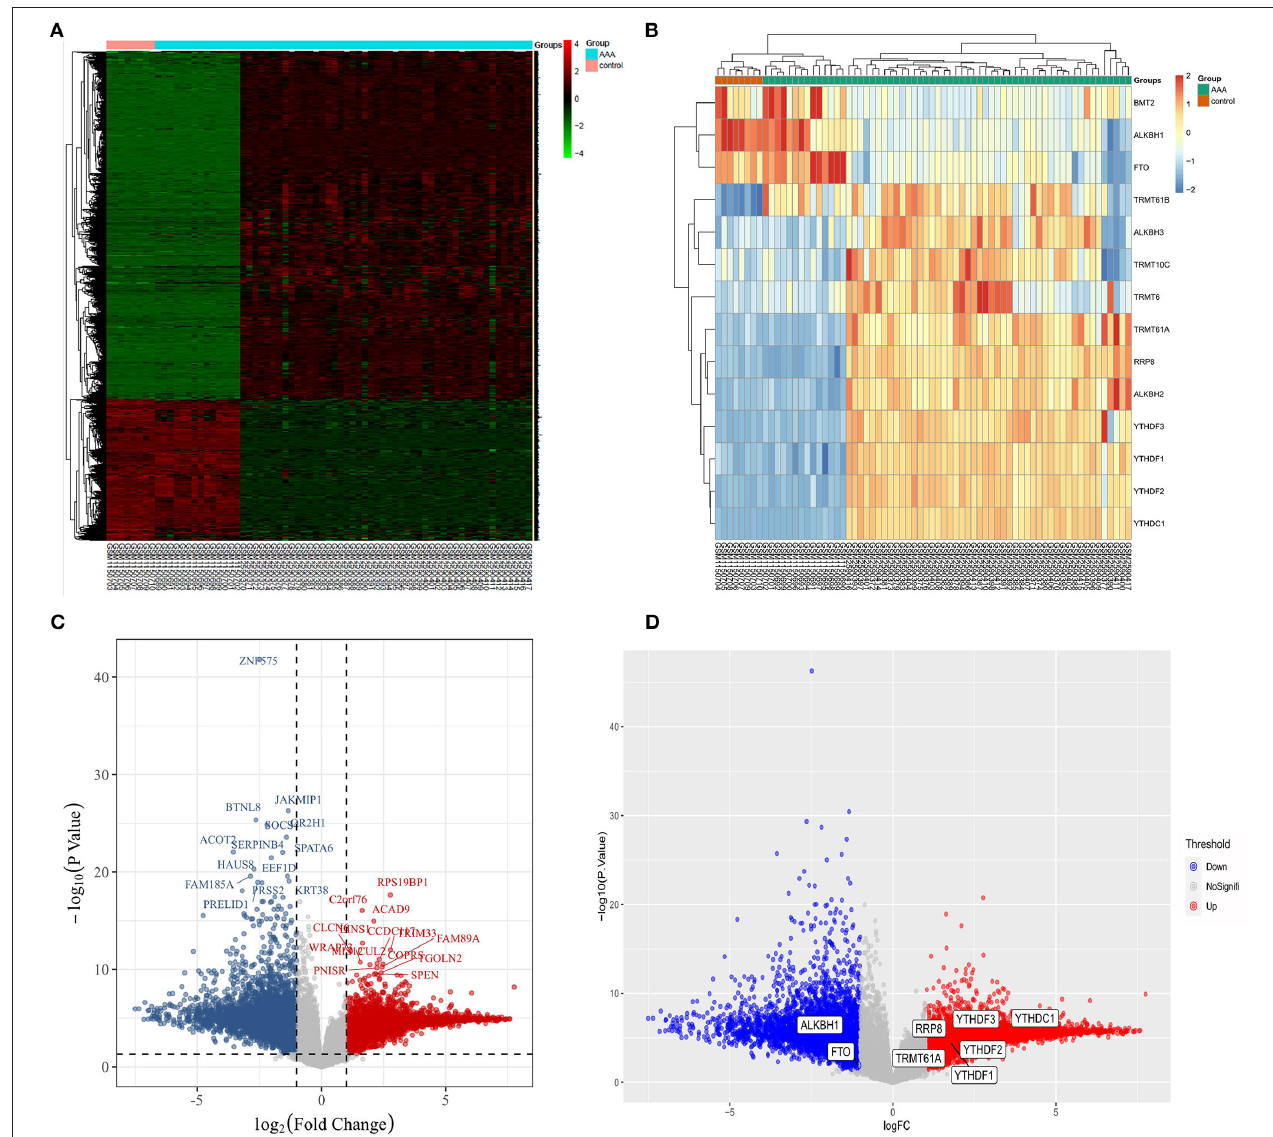
FIGURE 1 | Screening of differentially expressed m1A regulatory genes in AAA. (A) Overall heat map of the differential expression analysis; (B) The expression pattern of 14 common m1A regulators in AAA and control samples; (C) The volcano plot of DEGs in AAA, red represents up-regulated genes and blue represents down-regulated; (D) The volcano plot showing 8 DEMRGs in AAA, red represents up-regulated genes and blue represents down-regulated